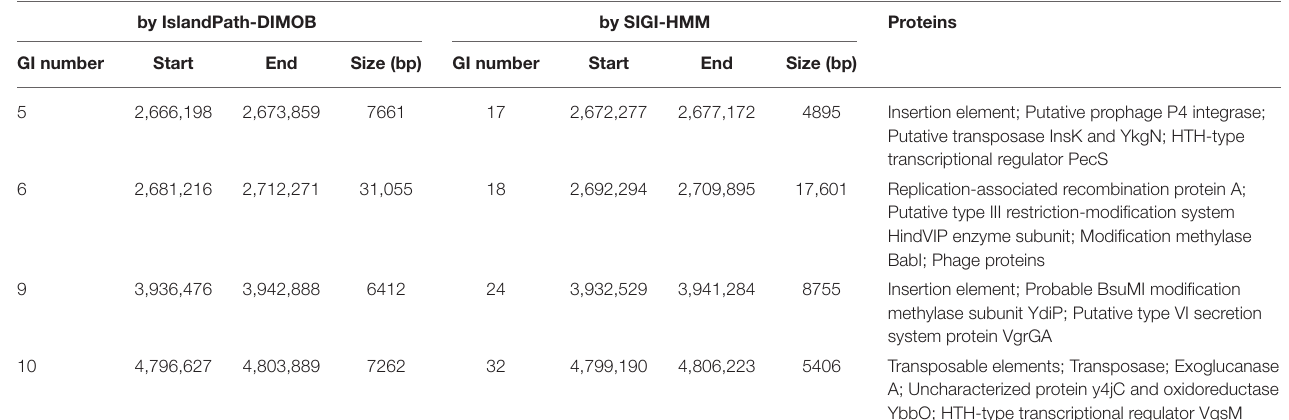
TABLE 2 | Overlapping Genomic islands predicted by IslandViewer 3